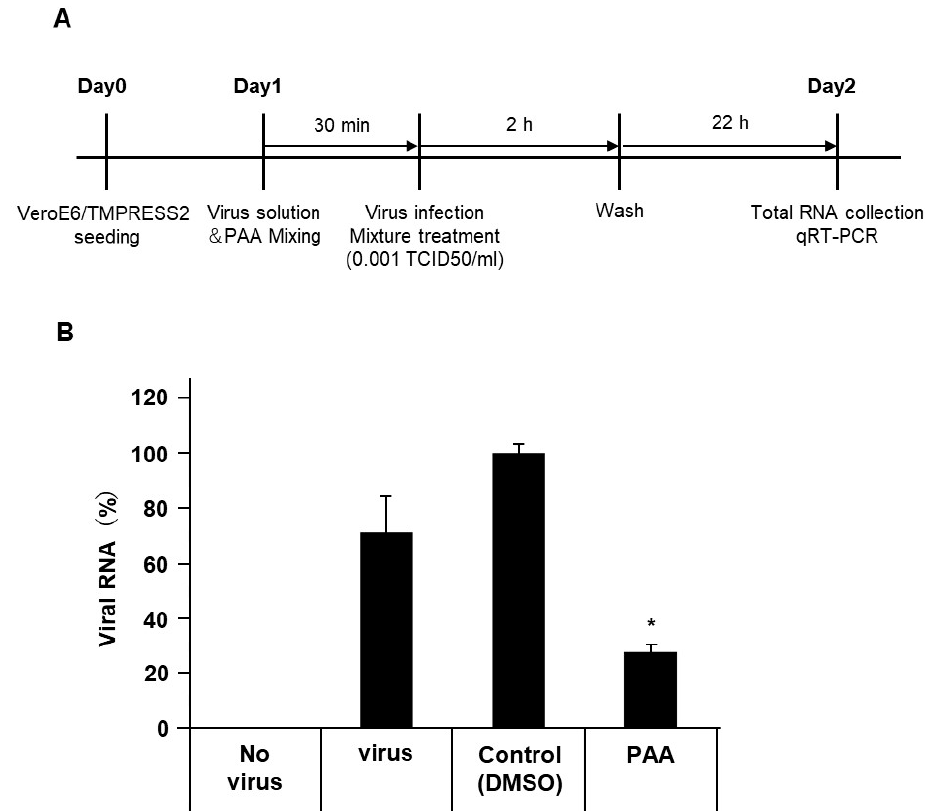
Figure 5. PAA reduced the SARS-CoV-2 viral load. The authentic SARS-CoV-2 solution was pre- treated with PAA (0.0018%) for 30 min. After infection of VeroE6/TMPRSS2 cells, SARS-CoV-2 viral loads were measured using RT-qPCR. ( A ) Schematic diagram illustrating the experimental design. ( B ) Reduction in authentic SARS-CoV-2 viral load by PAA treatment. Data from triplicate samples are expressed as means ± SD. Statistical analysis was performed using one-way ANOVA and subsequent Dunnett’s test. * indicates p < 0.05.